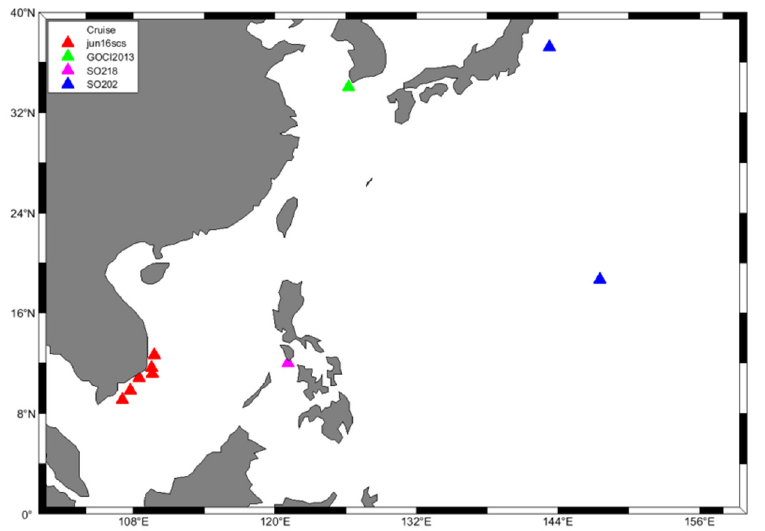
Figure 1. Locations of 10 in situ HPLC and satellite data, with the cruise name displayed in the